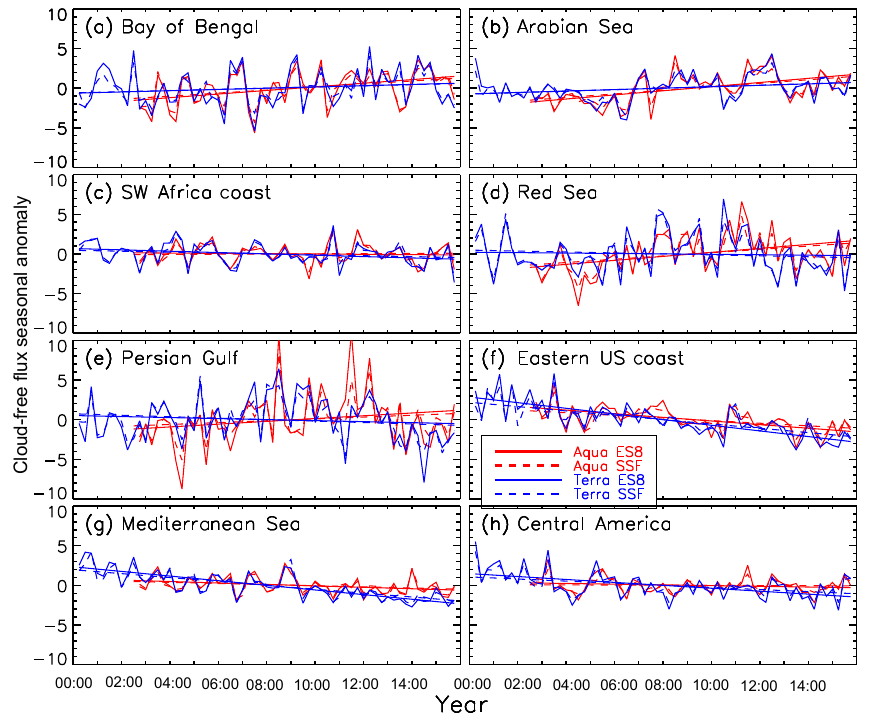
Figure 10. The temporal variations in deseasonalized, seasonally and regionally averaged CERES SSF/ES-8 cloud-free fluxes (seasonal anomaly) for eight selected regions, constructed using the collocated Aqua and Terra MODIS–CERES datasets. The blue lines represent the Terra-based analysis, while the red lines represent the Aqua-based analysis, and the solid lines represent the ES-8 SW fluxes, whereas the SSF SW fluxes are depicted by dashed